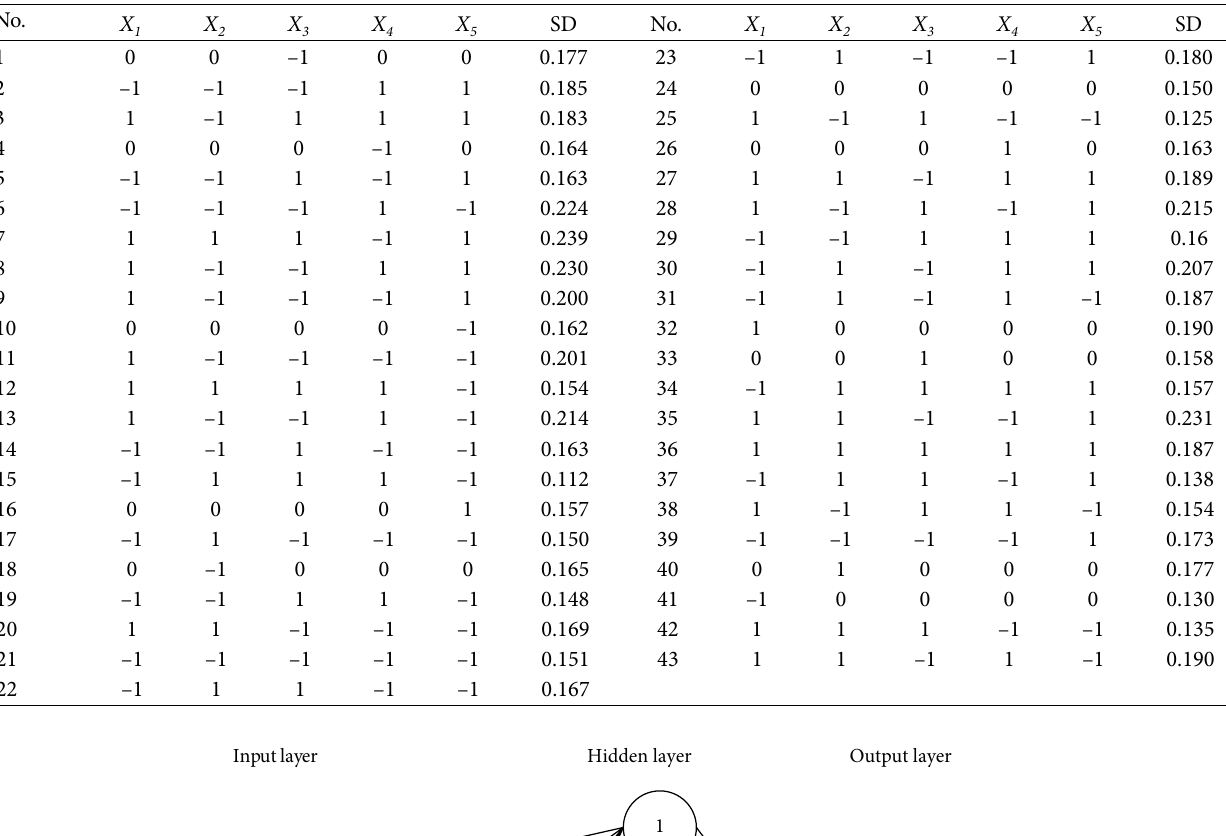
Table 2: Experimental matrix and corresponding results.